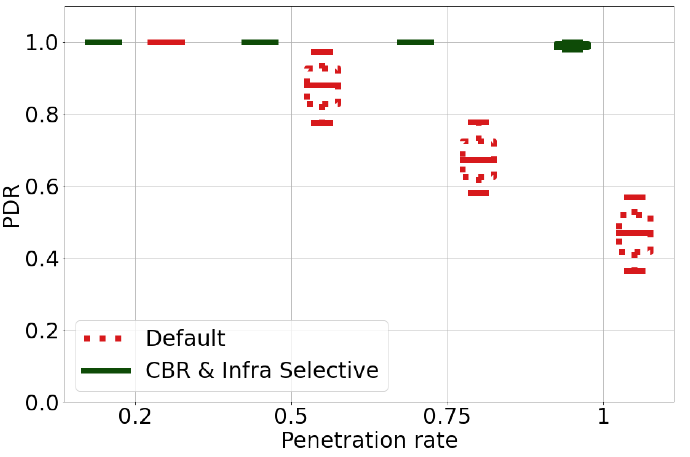
Figure 7. PDR function of penetration rate for Default, CBR & Infra selective algorithms.